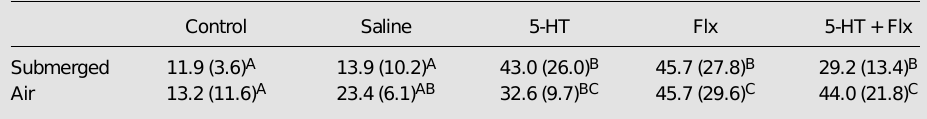
Table 2 - Effects of serotonin (5-HT), fluoxetine (Flx) and a mixture of both drugs (5-HT + Flx) on CHH levels (fmol/ml) in the hemolymph of Orconectes limosus . Animals were either kept submerged or exposed to atmospheric air after drug administration. Note that control animals were always kept submerged. Data are reported as mean ± SD. N = 6-10 animals in all cases. Same letters along a line indicate means not significantly different (P>0.05, ANOVA followed by Tukey multiple range